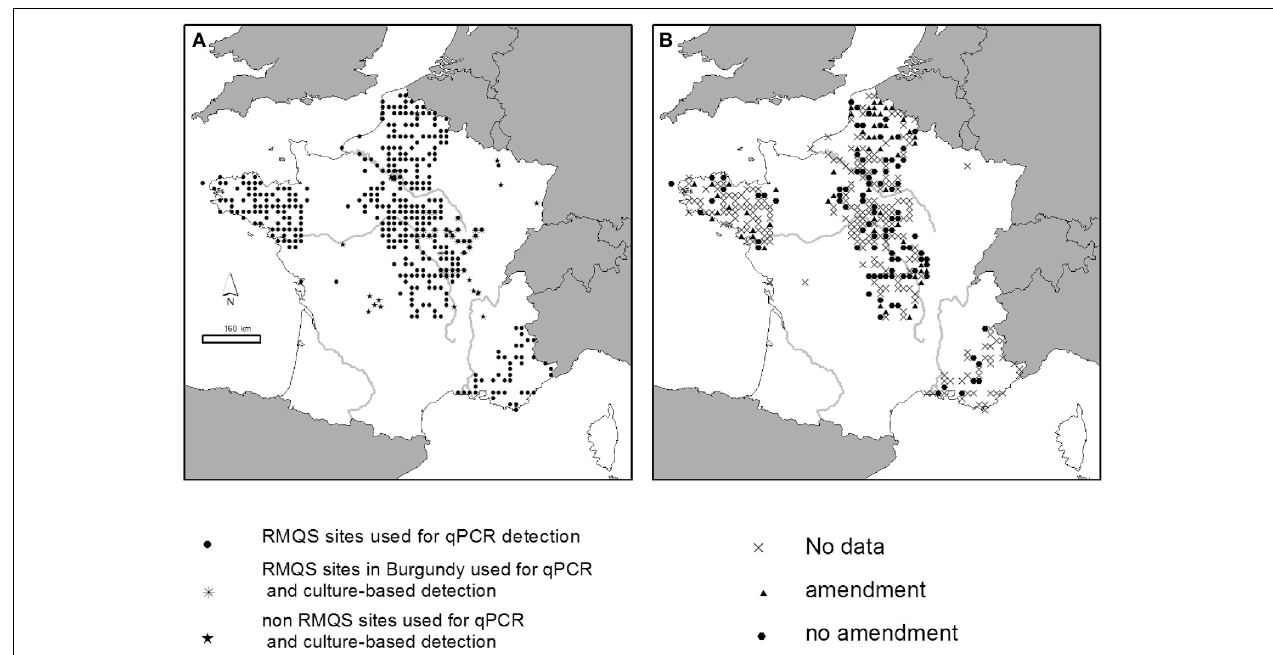
FIGURE 1 | Sites studied in France. (A) Soils used for qPCR and culture-based detection of P. aeruginosa . (B) Soils that received or not organic